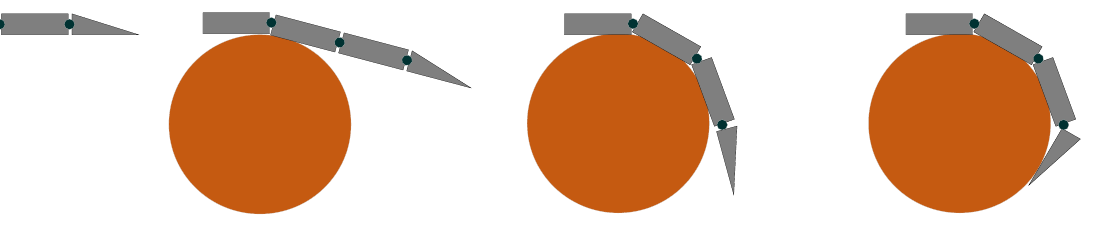
Figure 12. Control sequence of each joint of manipulator.